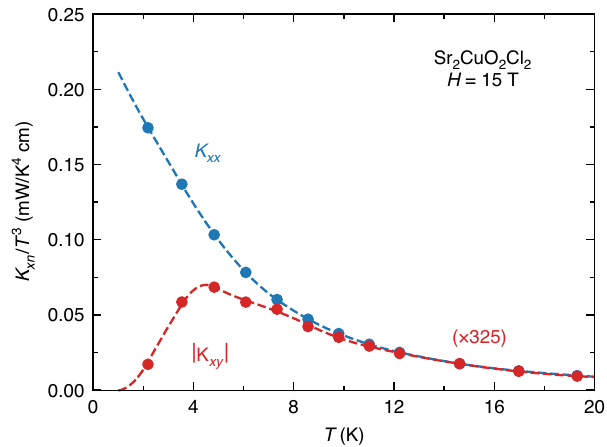
Fig. 7 Low-temperature regime in Sr 2 CuO 2 Cl 2 . Thermal conductivity κ xx and thermal Hall conductivity κ xy of Sr 2 CuO 2 Cl 2 (sample A), plotted as κ xx / T 3 (blue) and − κ T 3 (red) vs T . The dashed lines are a guide to the eye. xy / Note that the κ xy data are multiplied by a factor 325, to compare them more easily with κ xx , using only one y -axis